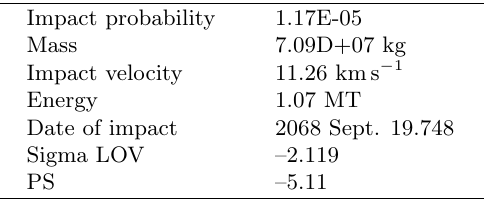
Table 3. Asteroid 2000 SG344. Possible impact solutions for the year 2068.